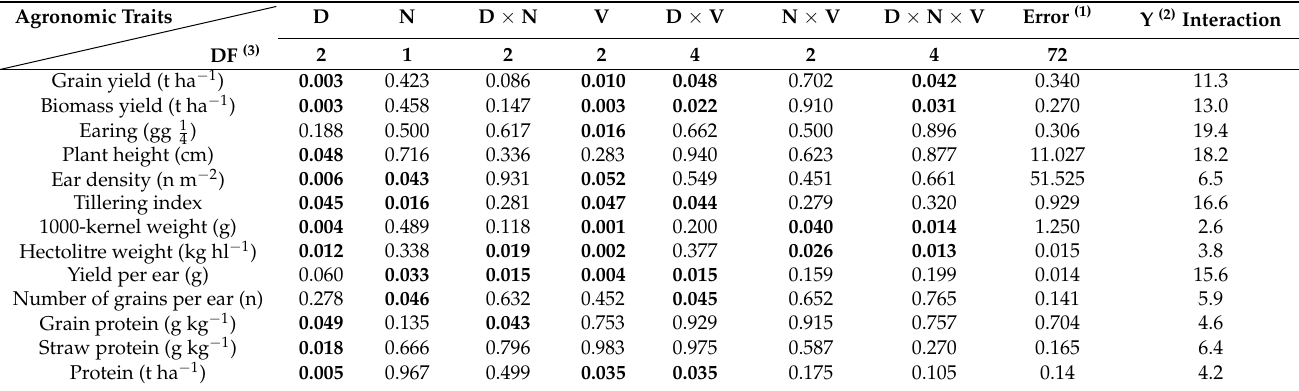
(1) Error variance. (2) Variance associated with the effects of the Year by treatment (fixed effects) interaction expressed as a percentage of the sum of the total variance associated with the effect of Year. (3) DF—degree of